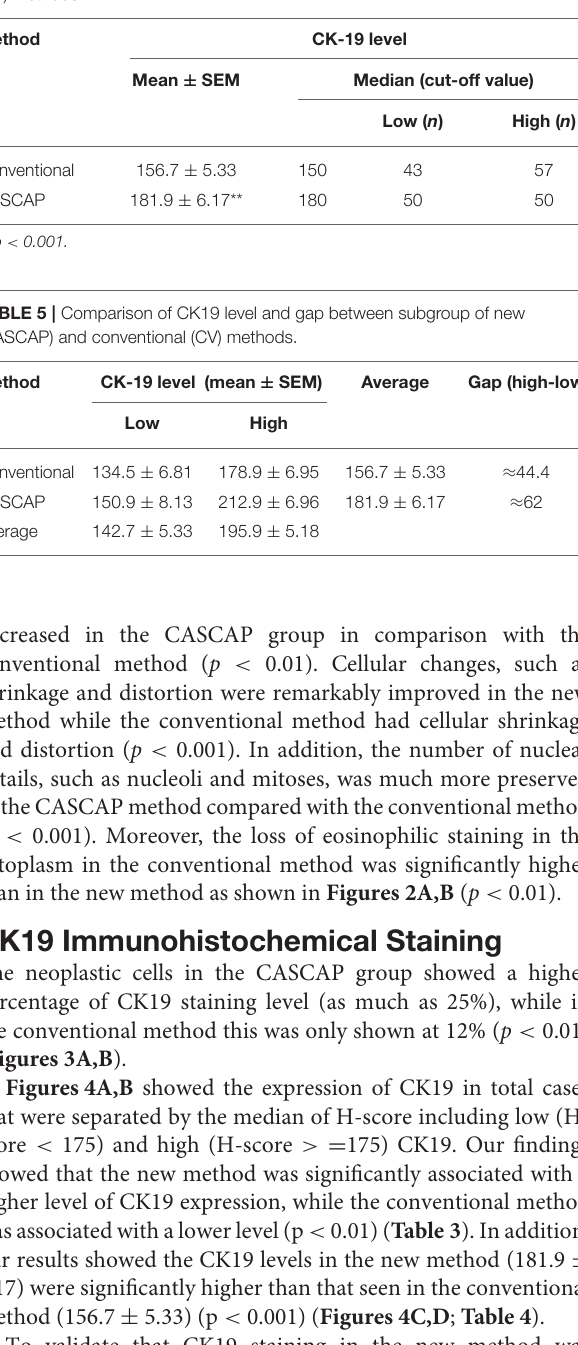
TABLE 4 | Comparison of CK19 levels between new (CASCAP) and conventional (CV) methods.